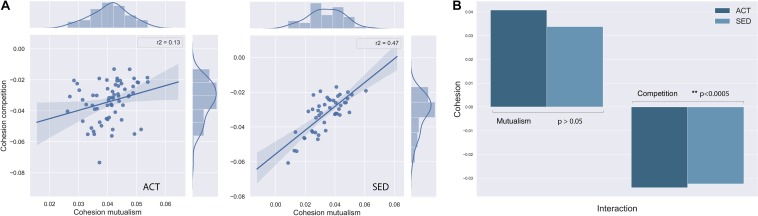
(A) Mutualism-competition complexity network relationship in ACT and SED groups, that shows network coupling in SED individuals. (B) Bar diagrams that compare mutualism and competition complexity averaged in both groups, where competitiveness was significantly different between SED and ACT individuals.